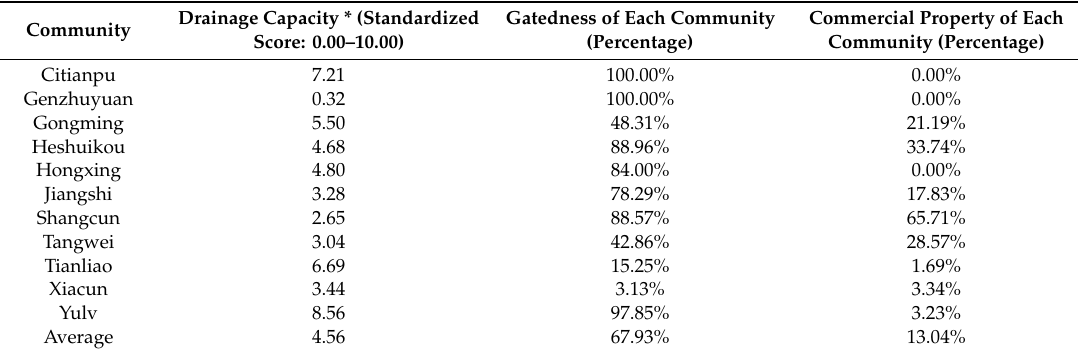
Table 3. External environmental attributes of each